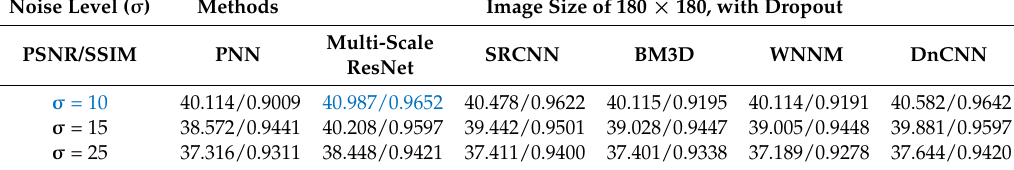
Table 6. The average results of our aerial-image model, where the multi-scale residual learning network (ResNet) was the proposed aerial-image denoising method in the paper. The corresponding experimental parameters were x = 5, y = 3, scaling parameter z = 4, and network depth of 26 (blue font indicates the best).